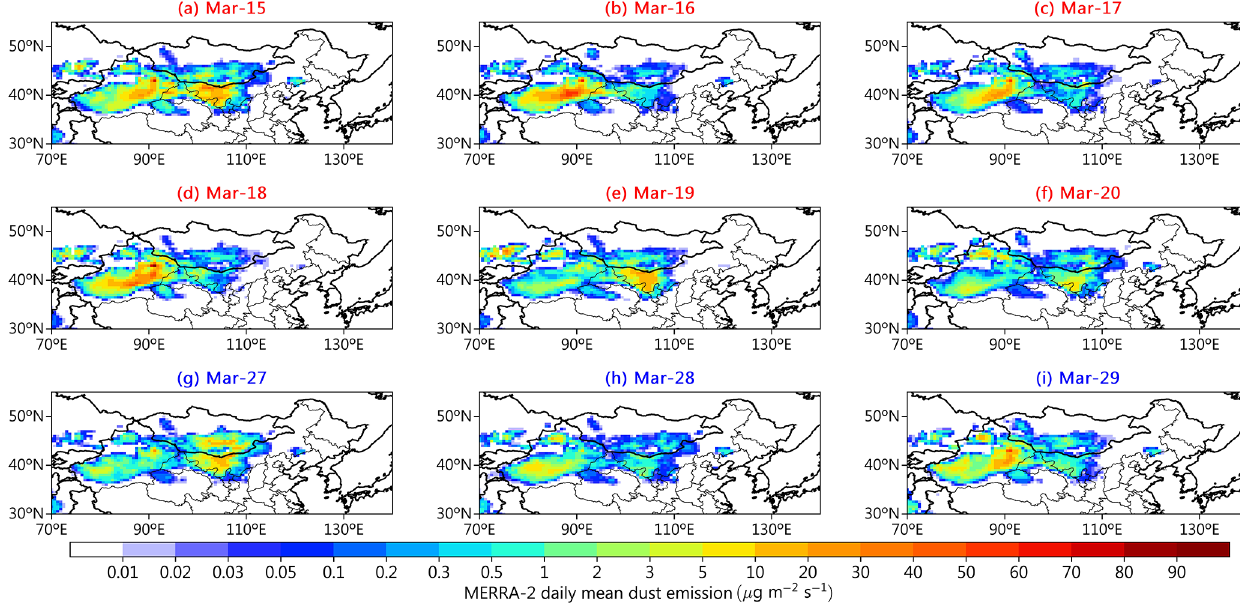
Figure 10. Evolution of MERRA-2 daily mean dust emissions for all size bins during (a–f) the 3.15 event and (g–i) the 3.27